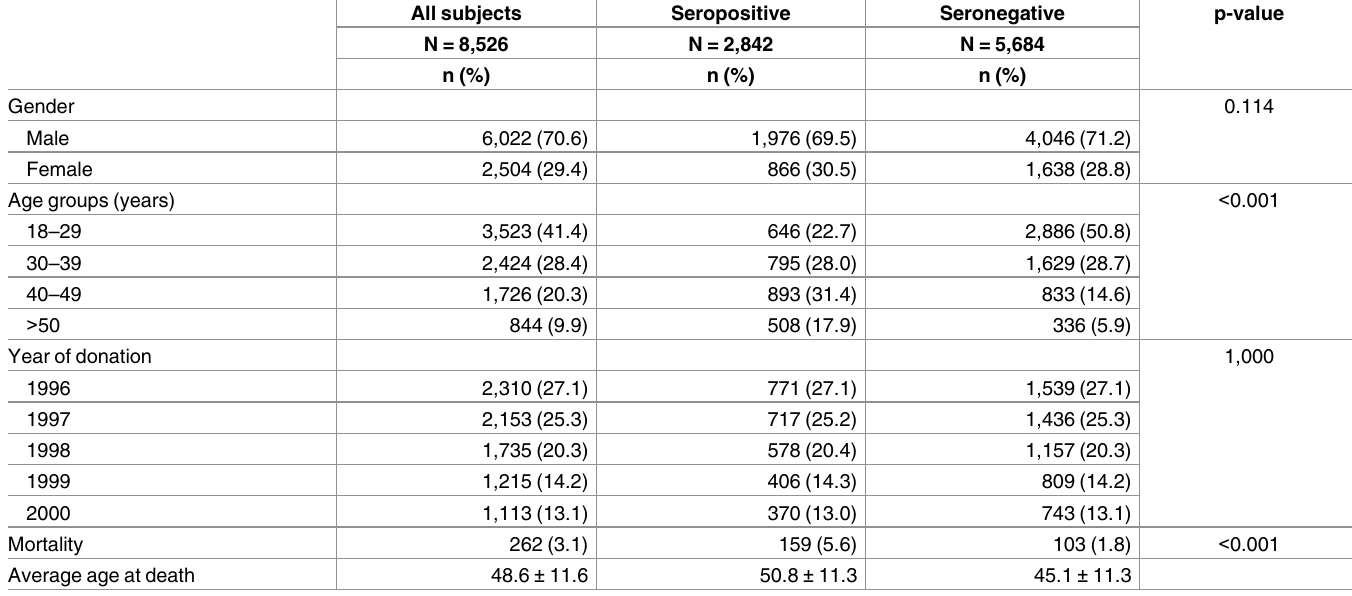
Table 1. Comparison of blood donors seronegative and seropositive for Chagas disease, at FPS, S ã o Paulo, Brazil, from 1996–2000, by age, gen- der, year of blood donation and mortality. All subjects